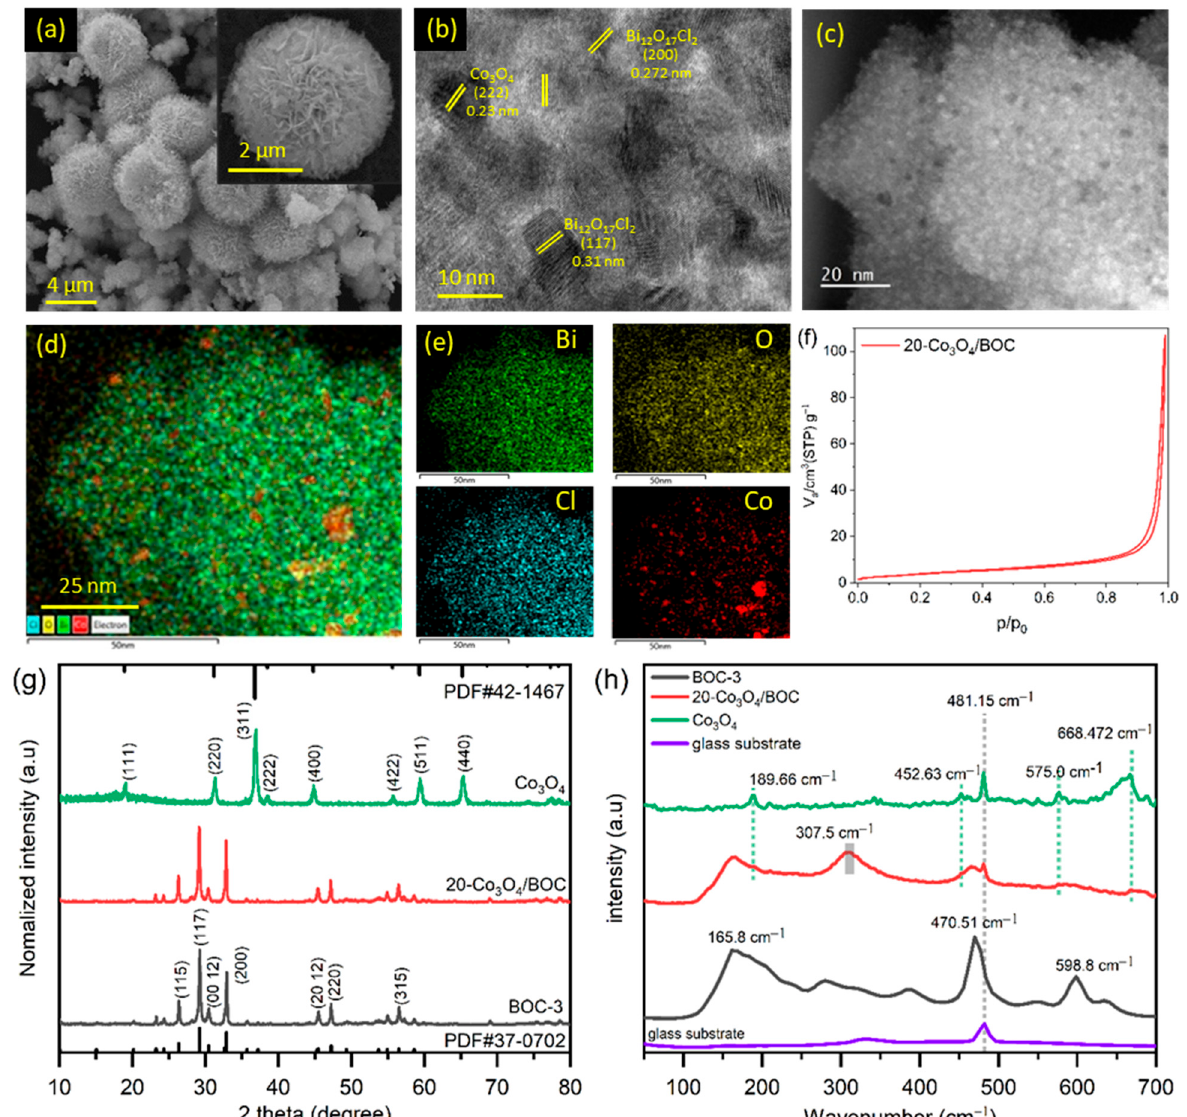
Figure 2. ( a ) FESEM image, ( b ) HRTEM image, ( c ) HAADF image, ( d ) EDX mapping, and ( e ) elemental EDX mapping of 20-Co 3 O 4 /BOC sample, ( f ) N 2 adsorption-desorption isotherm of 20-Co 3 O 4 /BOC, ( g ) XRD patterns, and ( h ) Raman spectra of Co 3 O 4 , BOC-3, and 20-Co 3 O 4 /BOC micro flowers.